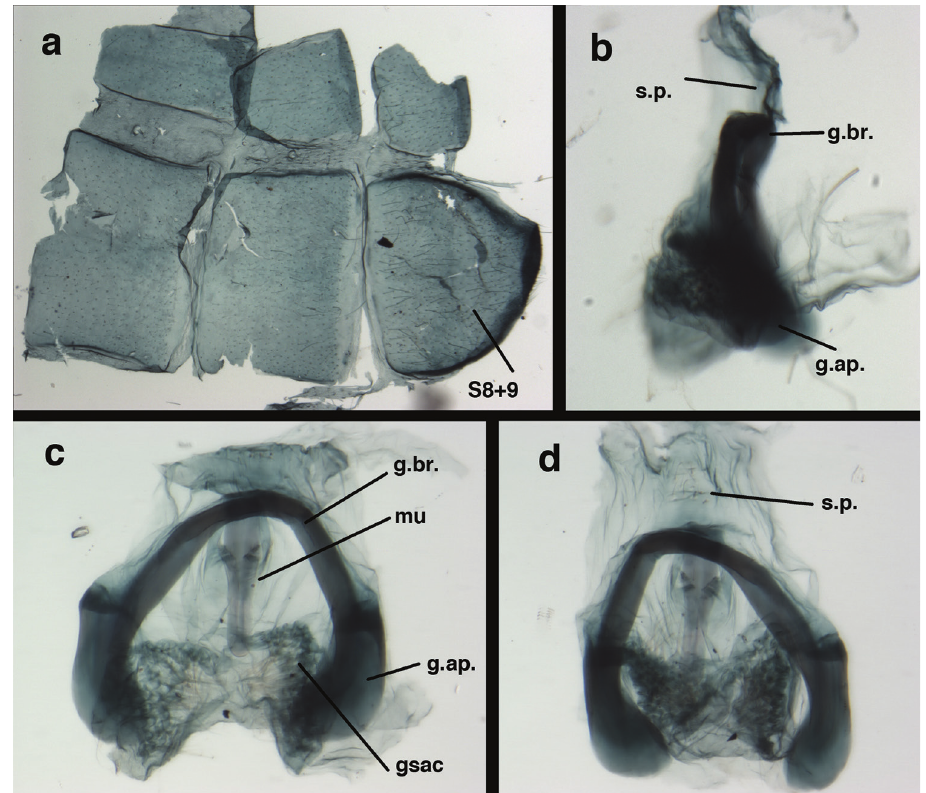
Figure 84. Chrysopa lambda Navás: Male terminalia, ( a ) integument of abdominal segments A6-termi- nus, dissected and flat ( b ) gonarcus, lateral ( c ) gonarcus, frontal ( d ) gonarcus, frontal, showing subanal plate above gonarcal bridge. gsac gonosaccus g.ap. gonarcal apodeme g.br. gonarcal bridge mu medi- uncus S8+9 fused eighth and ninth sternites s.p. setose subanal plate (Peru, Lima, lectotype,